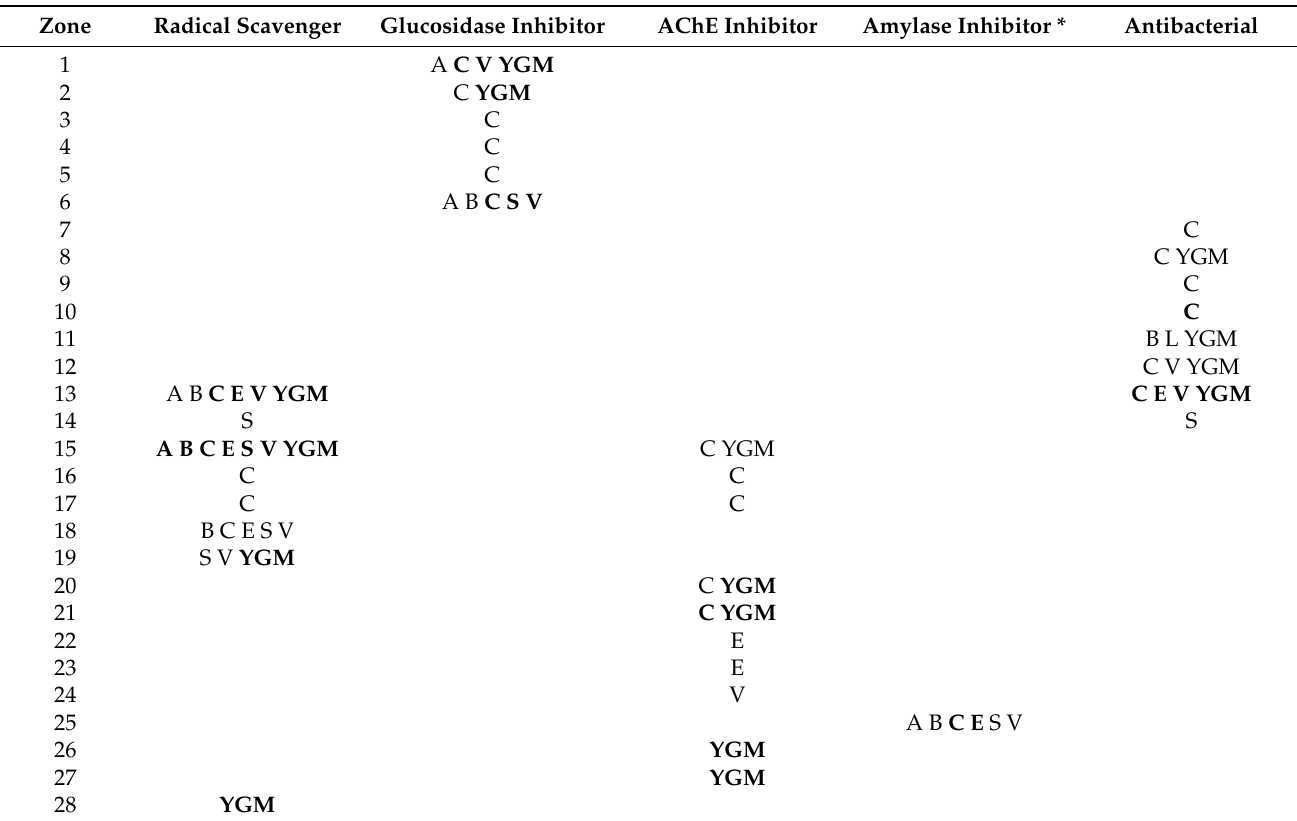
Table 2. Main bioactive zones 1 – 28 (Figures 1–3) observed in the monofloral honeys (as assigned in Table 1; honey with pronounced effect in